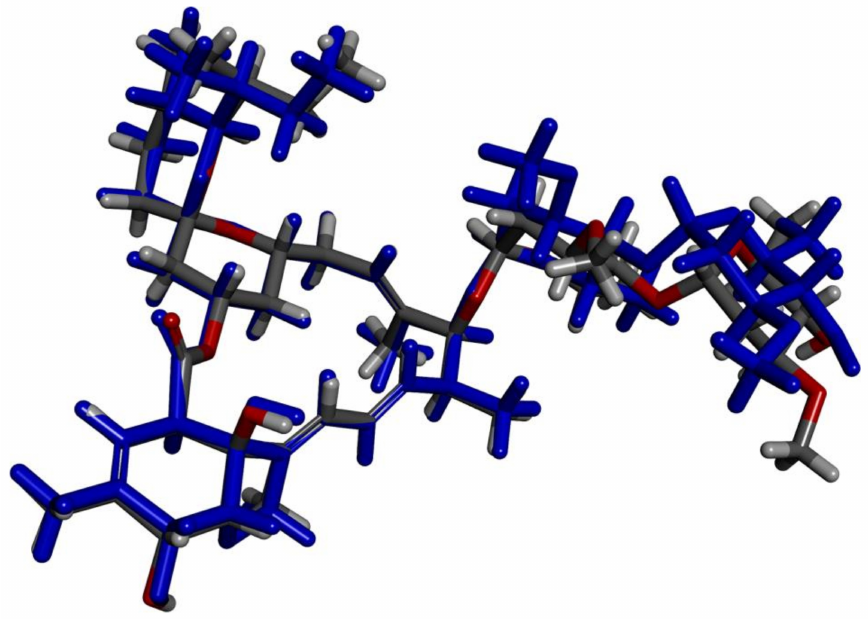
Figure 3. Overlay of IVM molecules present in crystal I as determined in the crystal structure (colored by elements) and after in vacuo geometry optimization